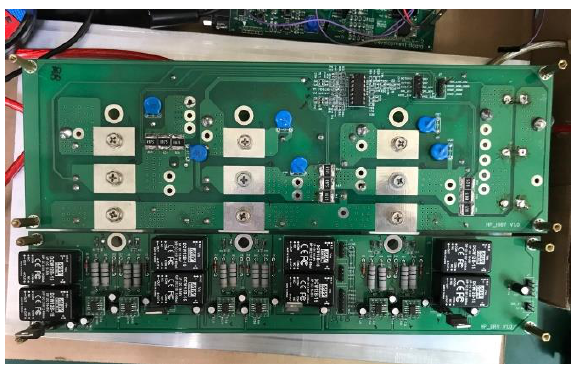
Figure 9. Integrated driving/braking inverter.